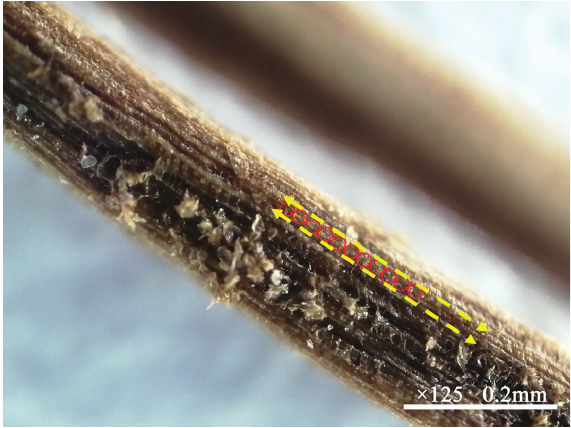
Figure 6: Fiber surface morphology (200 ×